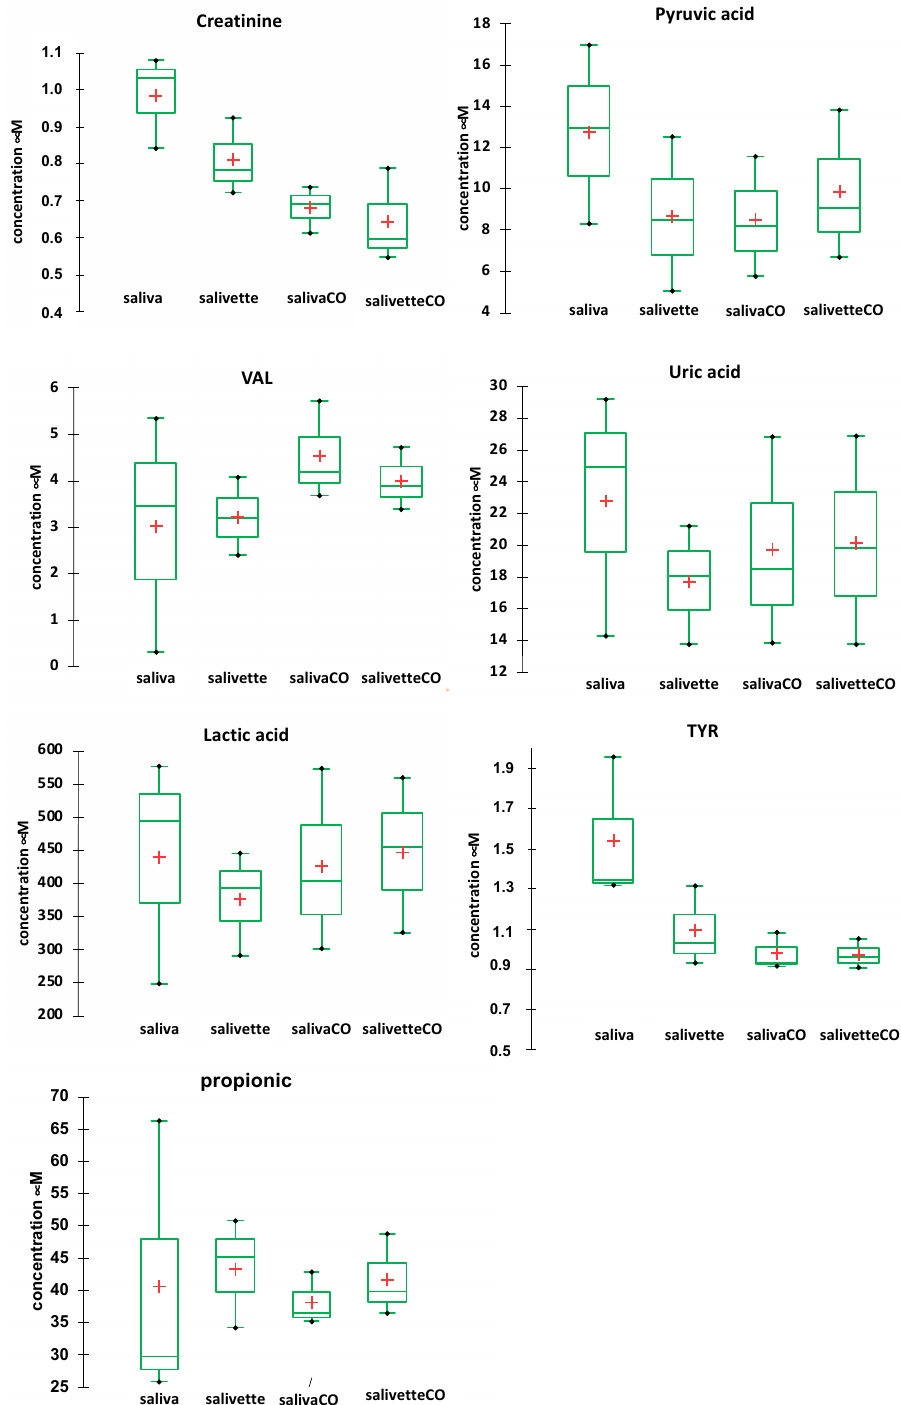
Figure 5. Box plots of the main metabolites determined in saliva/salivette samples before and after deproteinization with 3 kDa cut-off filtration. Red cross = mean value; black dots = minimum/maximum value; box = 1st quartile–3rd quartile range; bar = standard deviation.